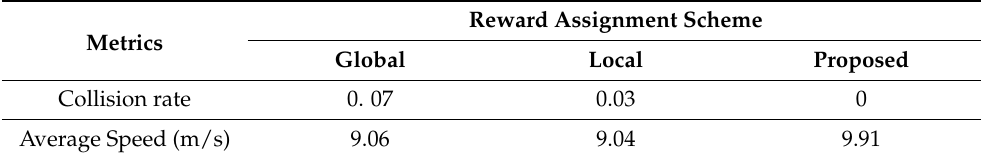
Figure 8. Comparison of the episode reward in the training using the different reward assignment schemes. Table 2. Performance comparison using the different reward assignment